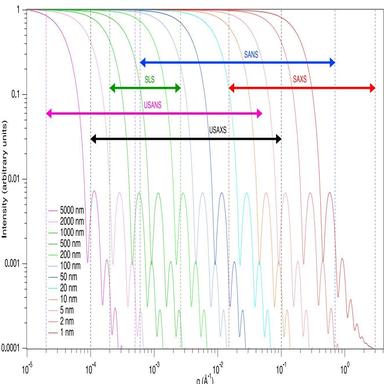
Normalised RGD form factors for spherical particles with 5 % polydispersity as a function of radius (shown in legend). Arrows indicate approximate q ranges for the elastic scattering techniques discussed. Actual q range will depend on the particular instrument. Graph highlights the ideal q range of different sized particles – for example SLS is ideal for particles from ~200–2000 nm. Data generated using SASView.